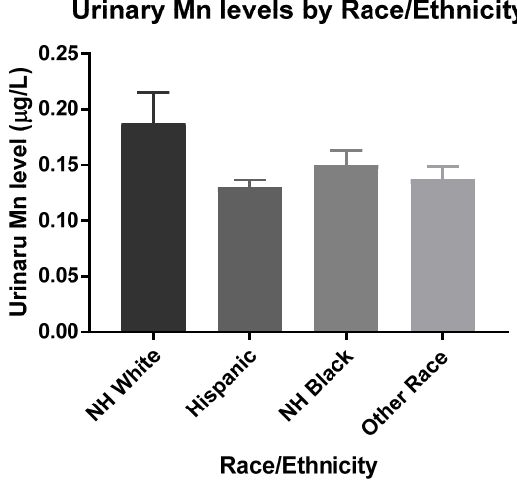
Figure 2. Estimated mean urinary Mn levels were 0.19, 0.13, 0.15, and 0.14 µg/L for NH-White ( n = 451), Hispanic ( n = 176), NH-Black ( n = 225), and Other Race ( n = 98), respectively. Data were analyzed by One-way ANOVA with Tukey’s post-hoc test holding NH White as the control. The limit of detection used was 0.13 µg/L.